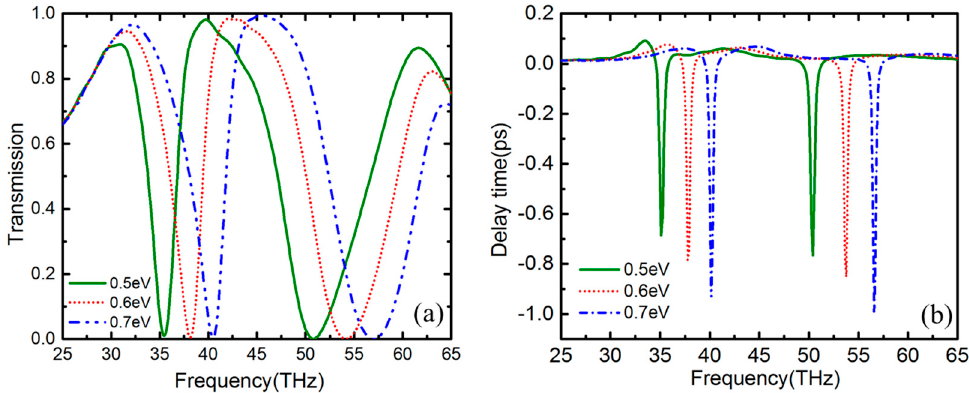
Figure 7. ( a ) Transparency spectrum for different Fermi energy of graphene from 0.5 to 0.7 eV. ( b ) Slow light region corresponding to different Fermi energy of graphene.